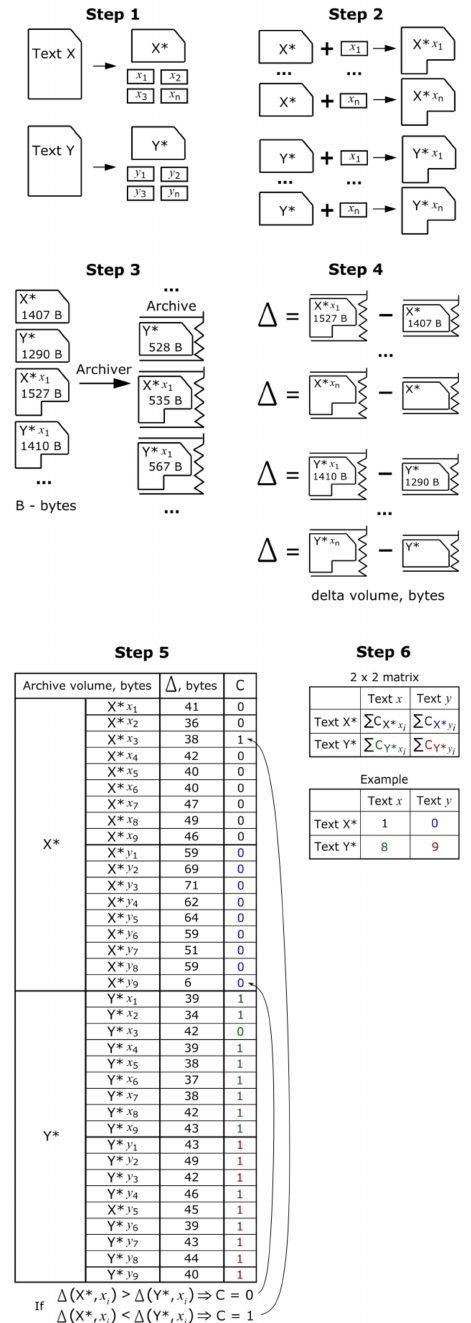
Figure A1. Here is a procedure for processing data to obtain the 2 × 2 matrices. Step 1. We divide each source file approximately in half. Then we leave the first half unchanged and divide the second one into several fragments of the same volume. The program that we used to cut text files is in the public domain: https: // github.com / m-novikov / sequence_cut. Step 2. To the first parts of the source files, we added individually the fragments containing behavioral sequences of the same species and thus obtained files: X*x 1 , Y*y 1 , etc. After that, to the first parts of the source files, we added individually the fragments containing sequences of another species and thus obtained files X*y 1 , Y*x 1 , etc. We thus obtained the augmented files and got a possibility to compare structural features of behavioral sequences of two species. Step 3. We now archive all files obtained individually. Step 4. For each pair of species, we calculate the di ff erence between the archive containing the augmented file and the first half of the source file. Step 5. We detect cases in which the di ff erence between the archive containing the augmented file and the first half of the source file was minimal and calculate the sum of numbers of these cases. Step 6. We place the obtained data into the cells of the 2 × 2